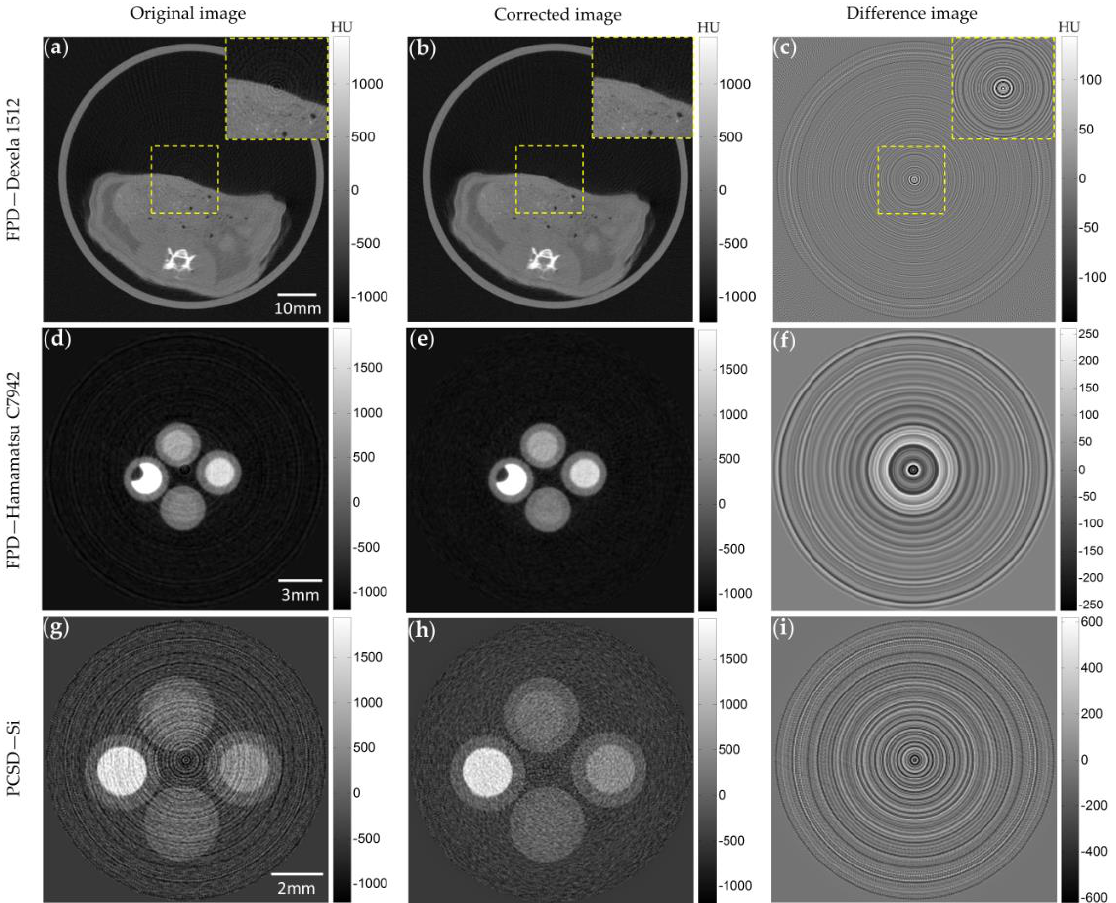
Figure 6. Ring artifact correction results. The first row shows the images of a rat taken by the Dexela 1512 FPD, and the second and third rows show the images of a contrast phantom taken by the C7942 FPD and the PCXD, respectively. The first column shows the original images obtained with applying the flat-field correction, and the second column shows the images corrected by the proposed method. The third column shows the difference images between the original and corrected images.